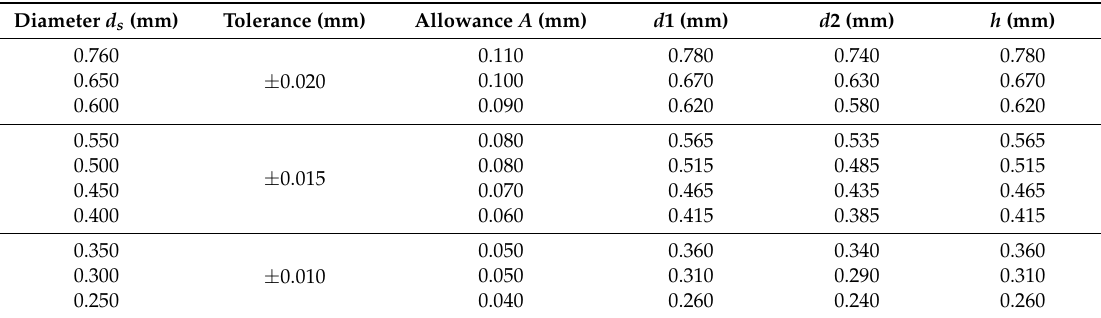
Table 1. Singularization hole main dimensions according to the different manufacturing tolerances of the micro-spheres (solder balls: alloy: 63Sn–37Pb series eutectic composition). Diameter d s